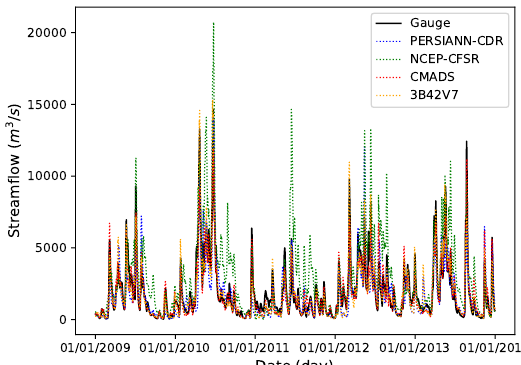
Figure 8. Comparison of simulated streamflow based on PERSIANN-CDR, NCEP-CFSR, CMADS, and 3B42V7 precipitation with that based on gauge